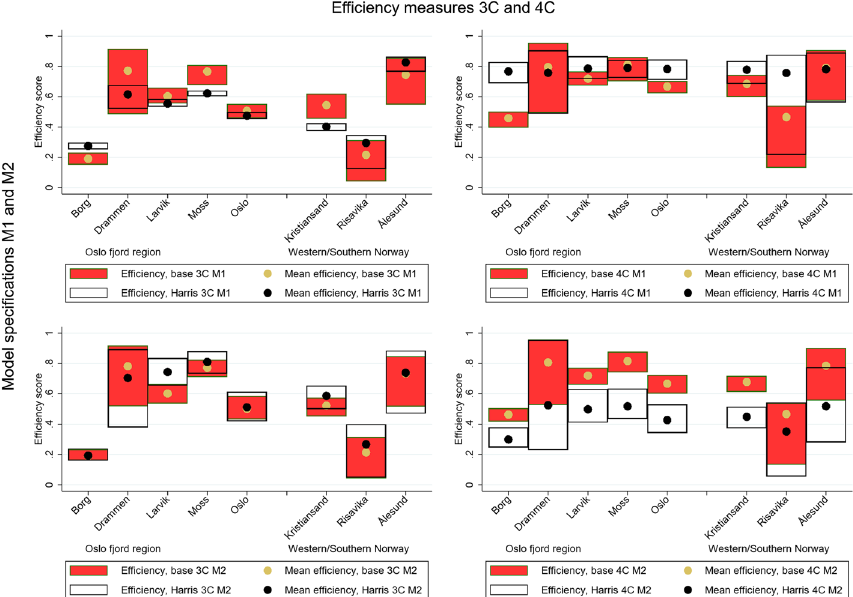
Fig. 4 Mean efficiencies and distributions per port for base and Harris measure model specifications with (M2) and without (M1) controls for unobservable intertemporal variations and efficiency measures 3C and